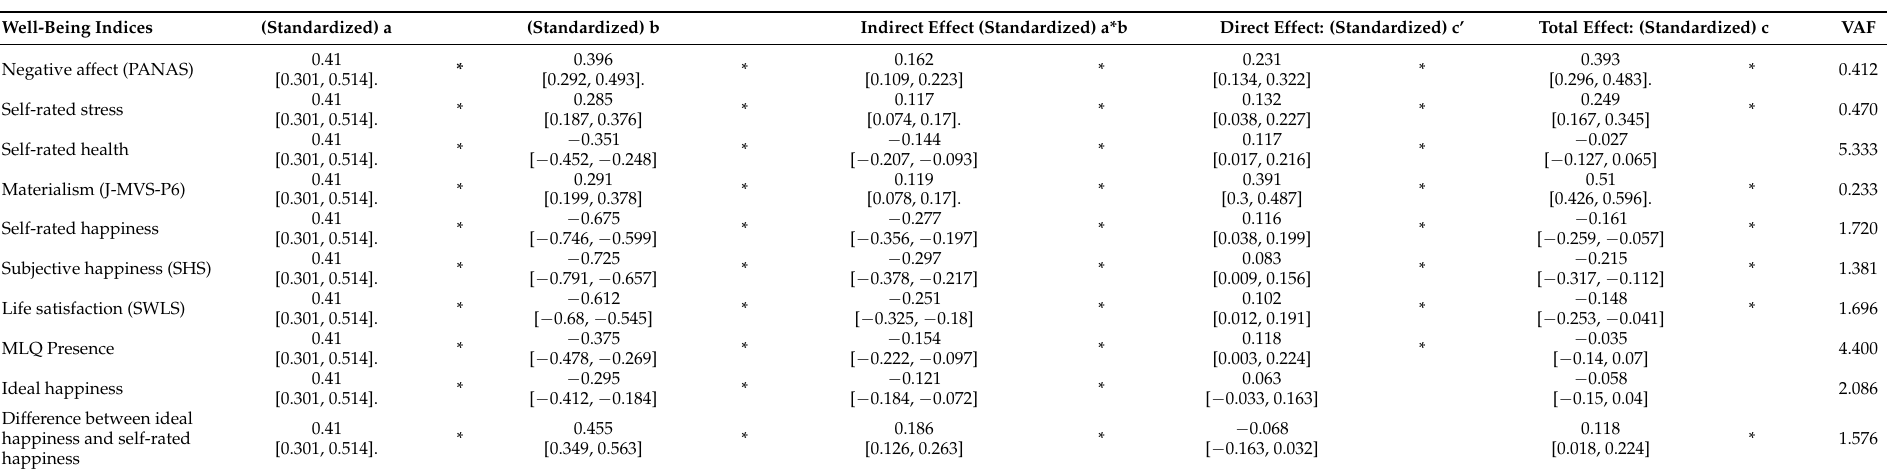
Table 4. Results of the mediation